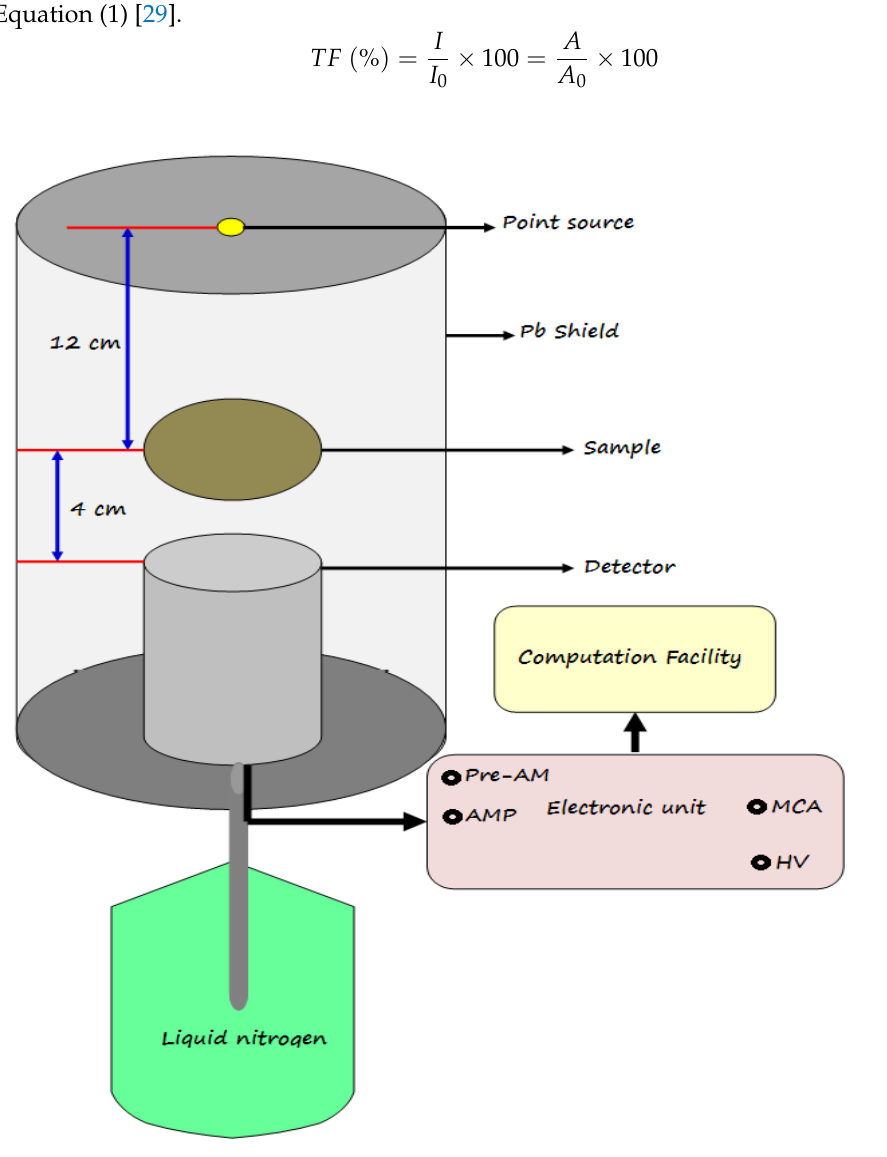
Figure 2. The geometry of the experimental work.